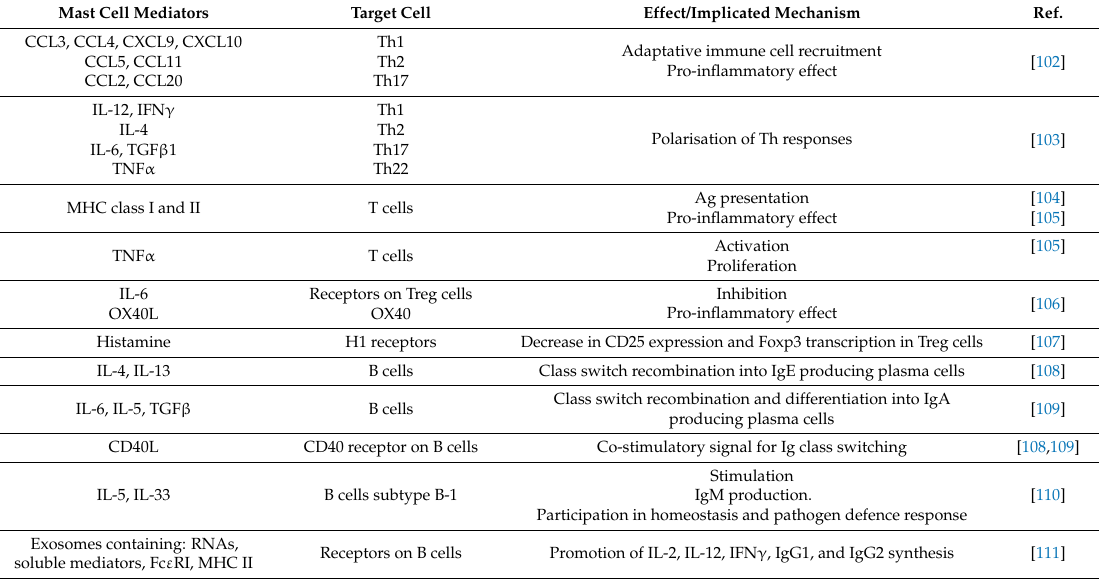
Table 4. Mast cell implication in adaptive